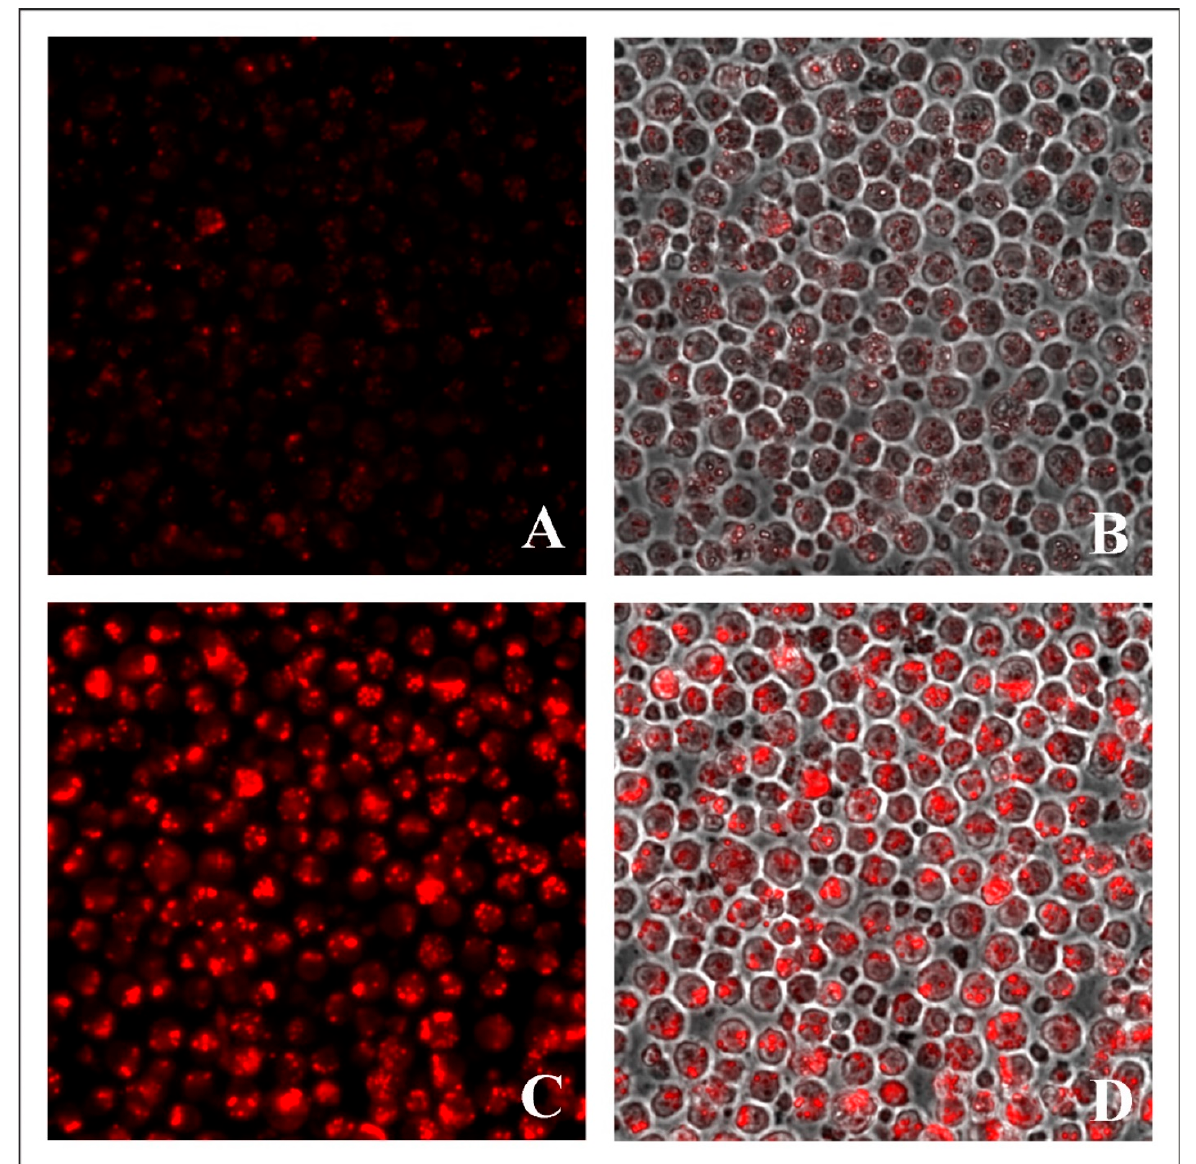
Figure 8. Ehrlich ascites carcinoma cell culture after 1.5 h ( A , B ) and 24 h ( C , D ) of incubation with BODIPY 1 at a concentration of 100 μ M. ( A , C )—fluorescent staining, ( B , D )—overlapping a fluorescent staining with the phase contrast image. Magnification 40×.